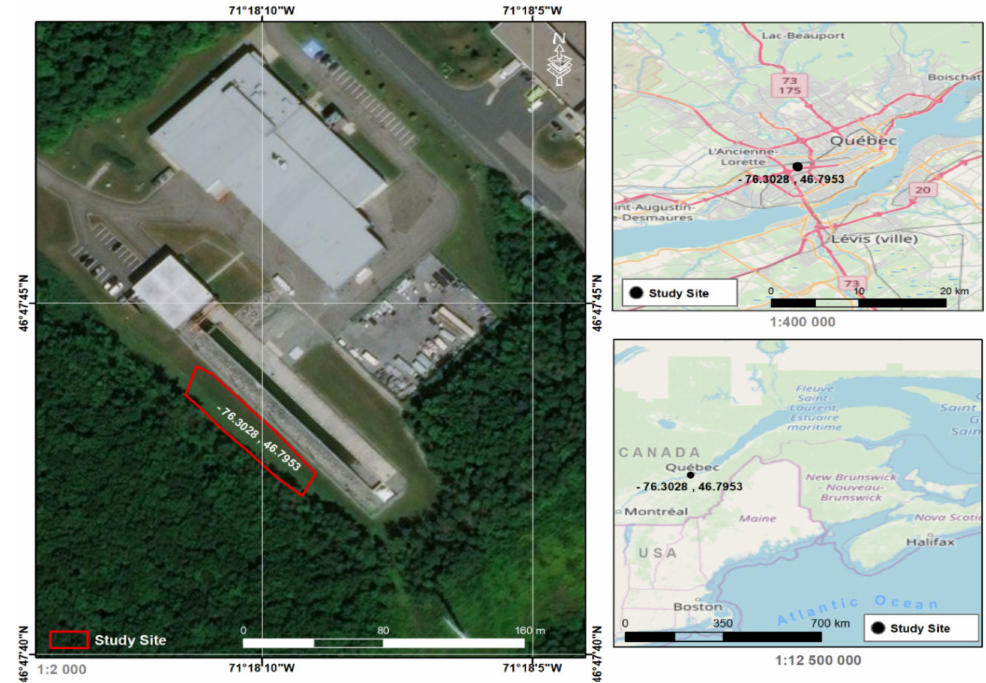
Figure 1. Geographical location of the sampling